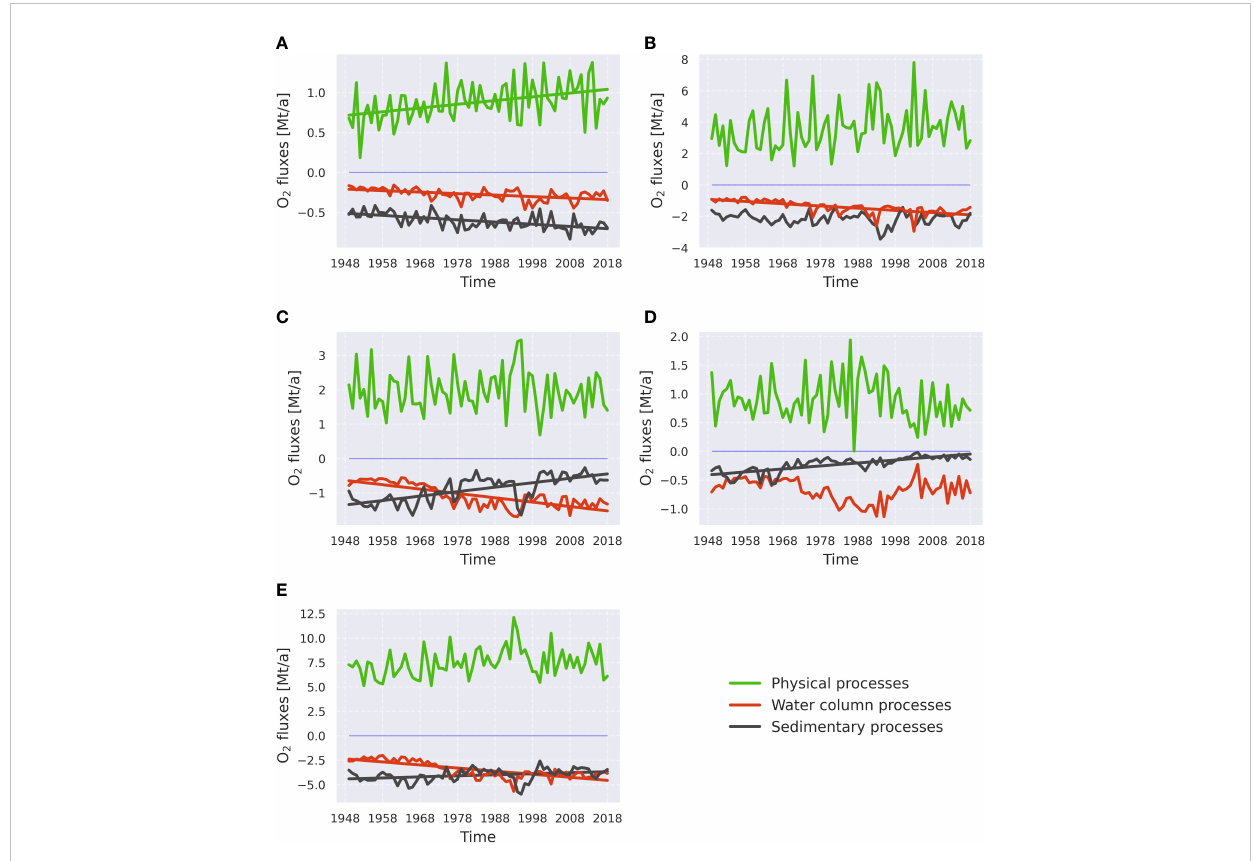
FIGURE 5 Linear trends of groups of processes governing oxygen dynamics in the sub-basins, namely the Bornholm Basin (A) , the eastern Gotland Basin (B) , the northern Gotland Basin (C) , the western Gotland Basin (D) , and the whole central Baltic Sea (E) . The groups of processes are identical to those in Figure 4. Trend lines are only shown if they are signi fi cant (p<0.05). Mt/a stands for 10 9 kg per year. See Supplementary Table 1 for more information about processes in each